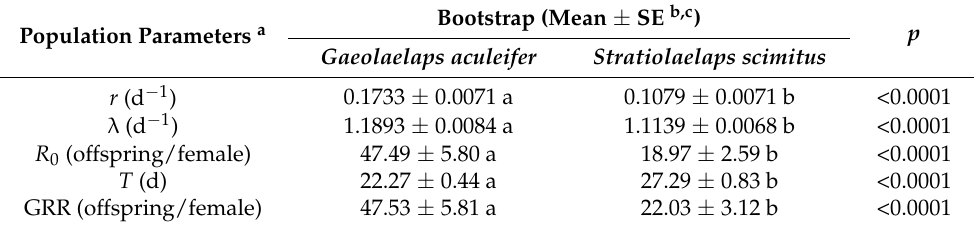
Table 2. Population parameter of G. aculeifer and S. scimitus fed on T. putrescentiae . Population Parameters